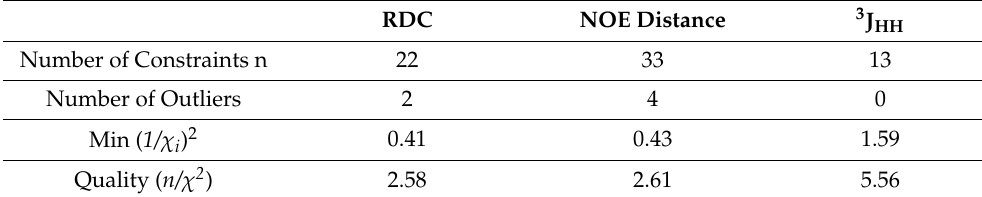
Table 2. Performance of the MDOC simulation of Strychnine. RDC NOE Distance 3 J HH Number of Constraints